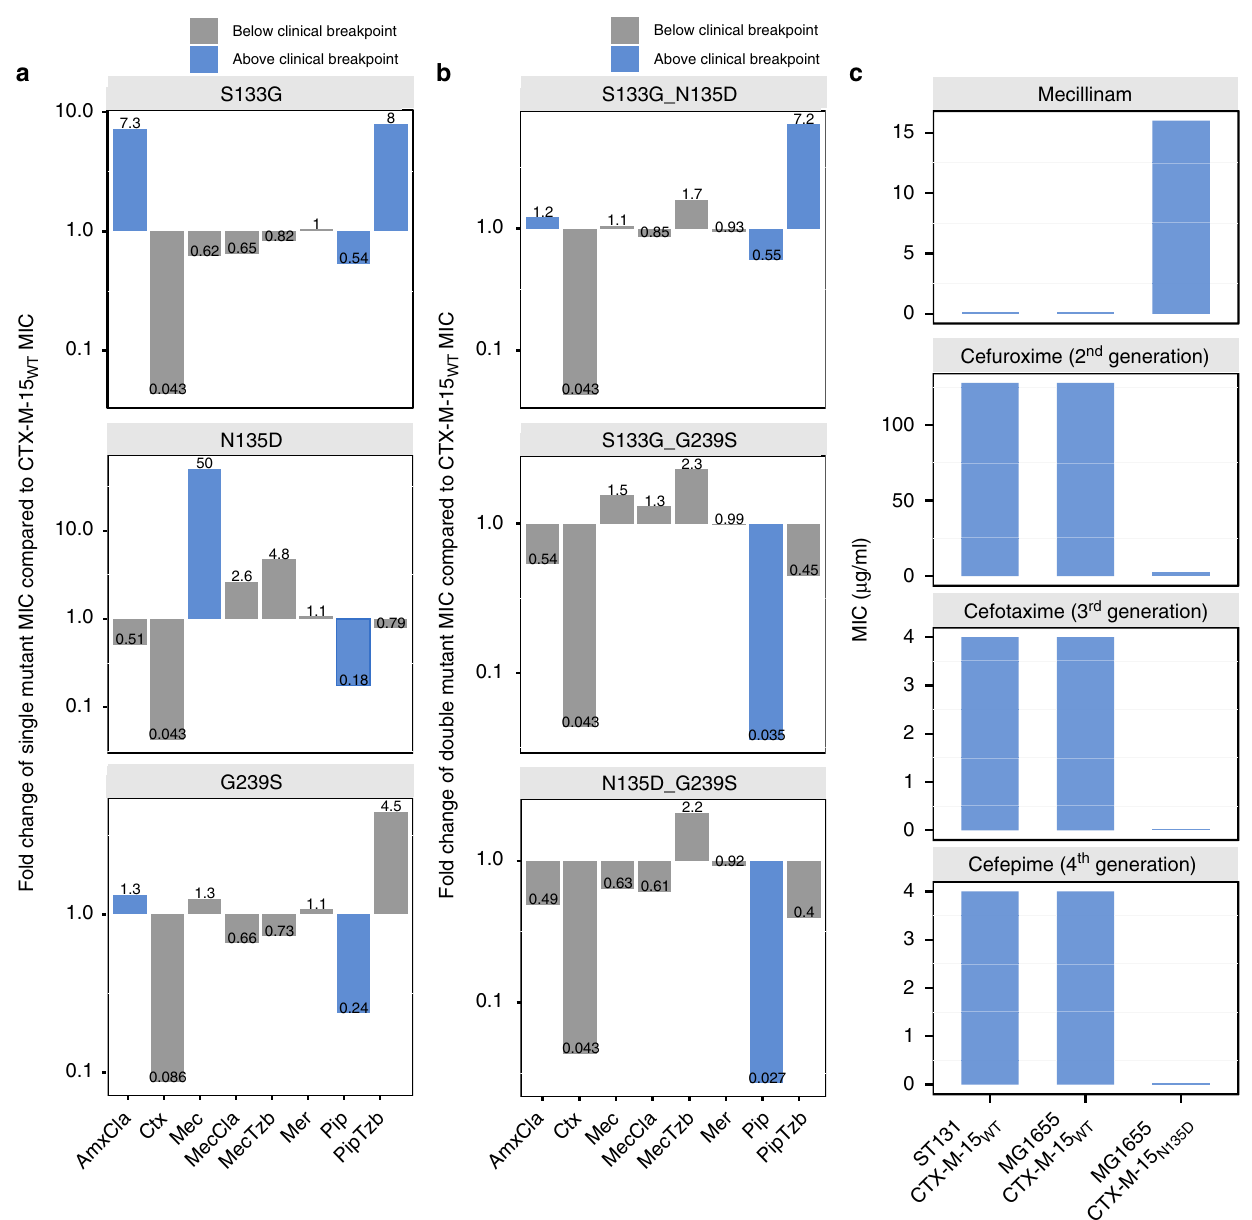
Fig. 2 Fold change of re-constructed mutants and MIC values for different CTX-M-15 carrying strains. a Fold change of the MIC of the indicated antibiotics for E. coli TOP10 expressing the indicated single mutants of CTX-M-15. Substantial collateral sensitivity and resistance results from individual mutants selected in speci fi c antibiotics. b Fold change of the MIC of the indicated antibiotics for E. coli TOP10 expressing double mutants of CTX-M-15. Negative epistasis is observed for all double mutants except CTX-M-15S133G_N135D towards piperacillin – tazobactam. Fold changes for single and double mutants are in relation to the MIC values of E. coli TOP10 expressing CTX-M-15WT. c The MIC was determined for the mecillinam-resistant mutant CTX-M- 15N135D against mecillinam and three different cephalosporins: cefuroxime (second generation), cefotaxime (third generation), and cefepime (fourth generation). Two different strains were used as wild-type (WT) controls of CTX-M-15: E. coli MG1655 and a clinical E. coli ESBL strain, ST131. E. coli MG1655 was used for expression of CTX-M-15N135D. Blue bars indicate MIC values above the clinical breakpoint (as de fi ned by the European Committee on Antimicrobial Susceptibility Testing (EUCAST) (Supplementary Table 1). AmxCla, Amoxicillin – clavulanic acid; Ctx, cefotaxime; Mec, mecillinam;